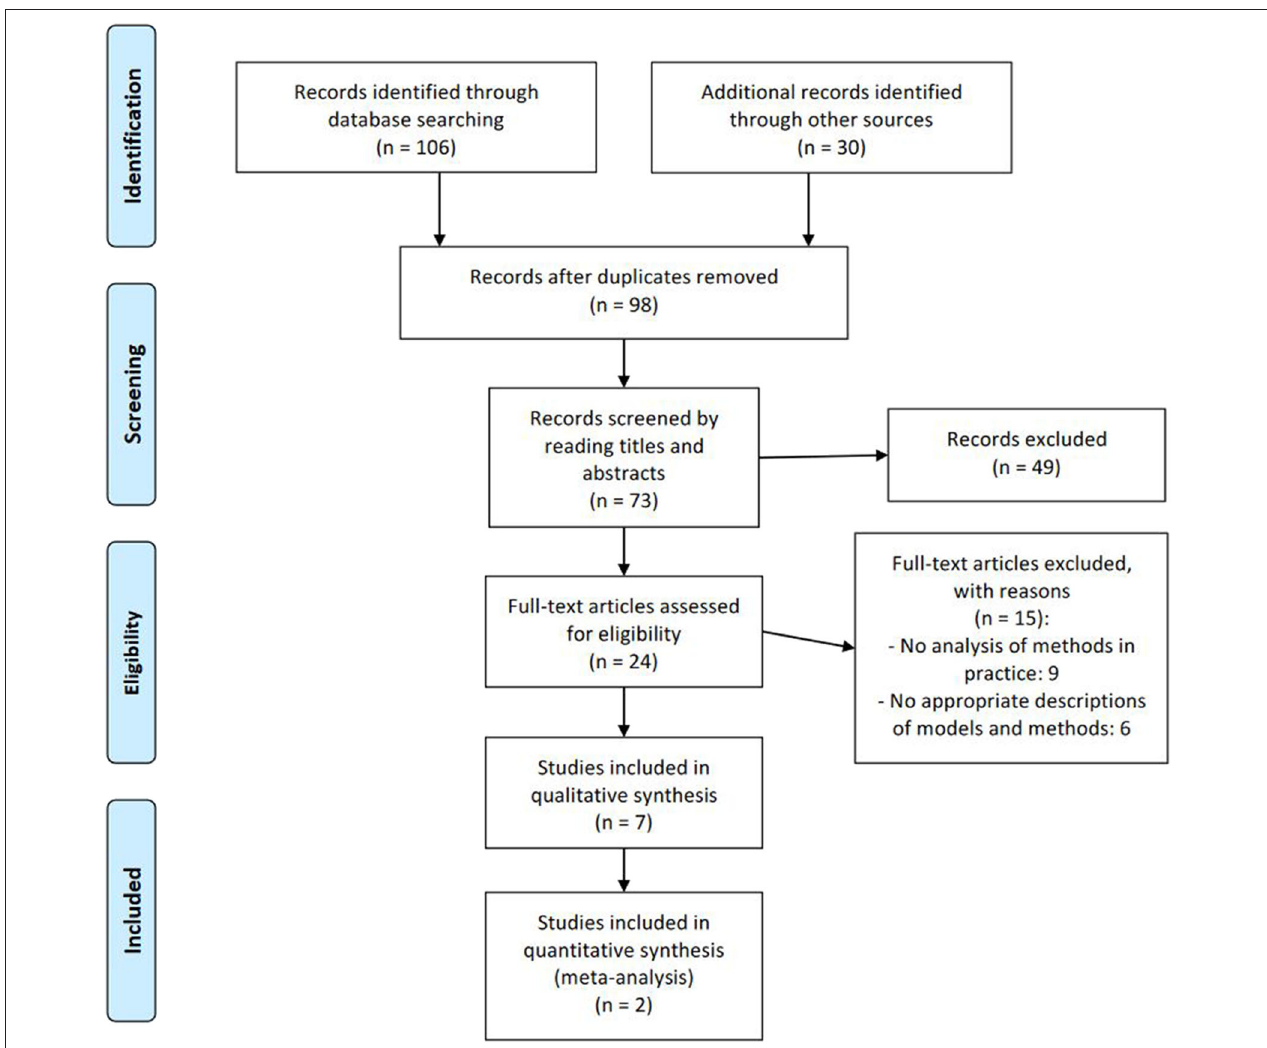
FIGURE 1 | Study selection flow diagram by PRISMA (Moher et al., 2009)